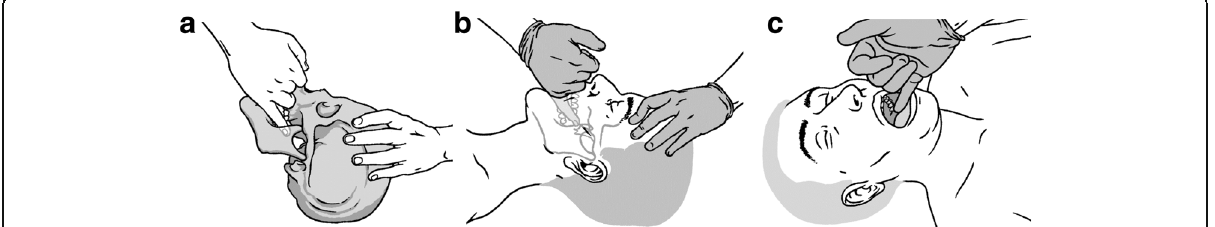
Fig. 2 a , b , c Intraoral myofascial therapy of the sphenopalatine ganglion. Position of the patient ’ s head and the osteopath ’ s fifth finger, during SPG